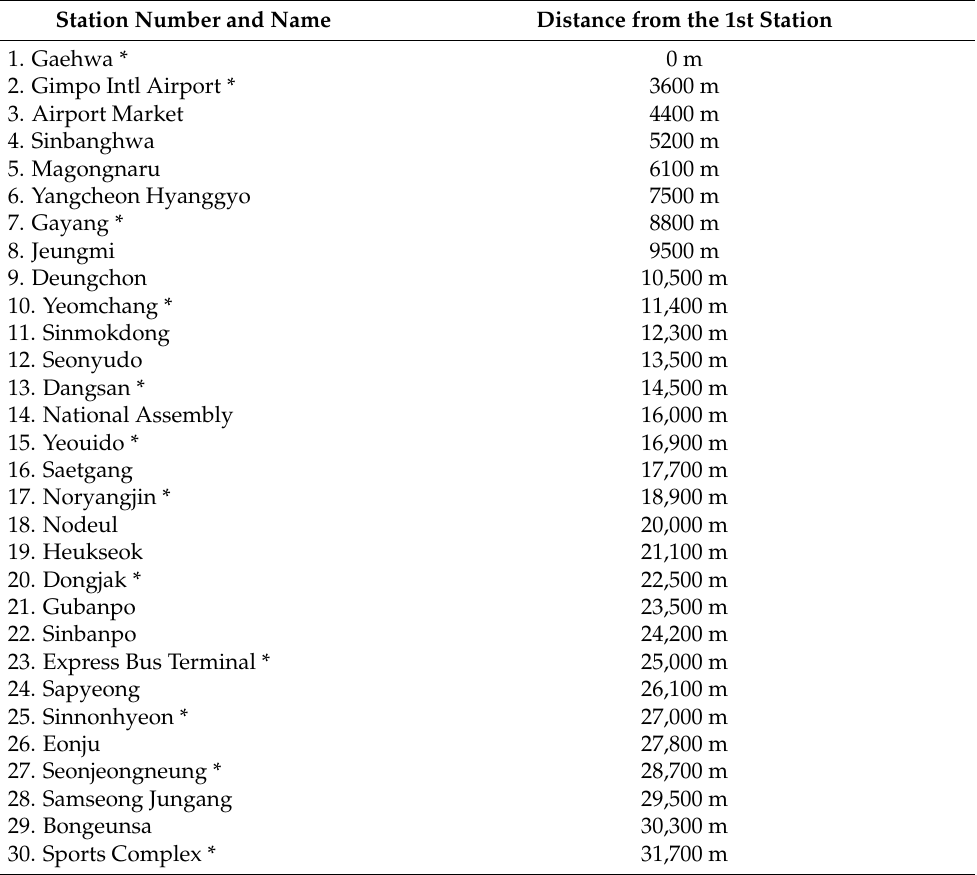
Table 1. Station information for Metro 9 in Seoul Metropolitan